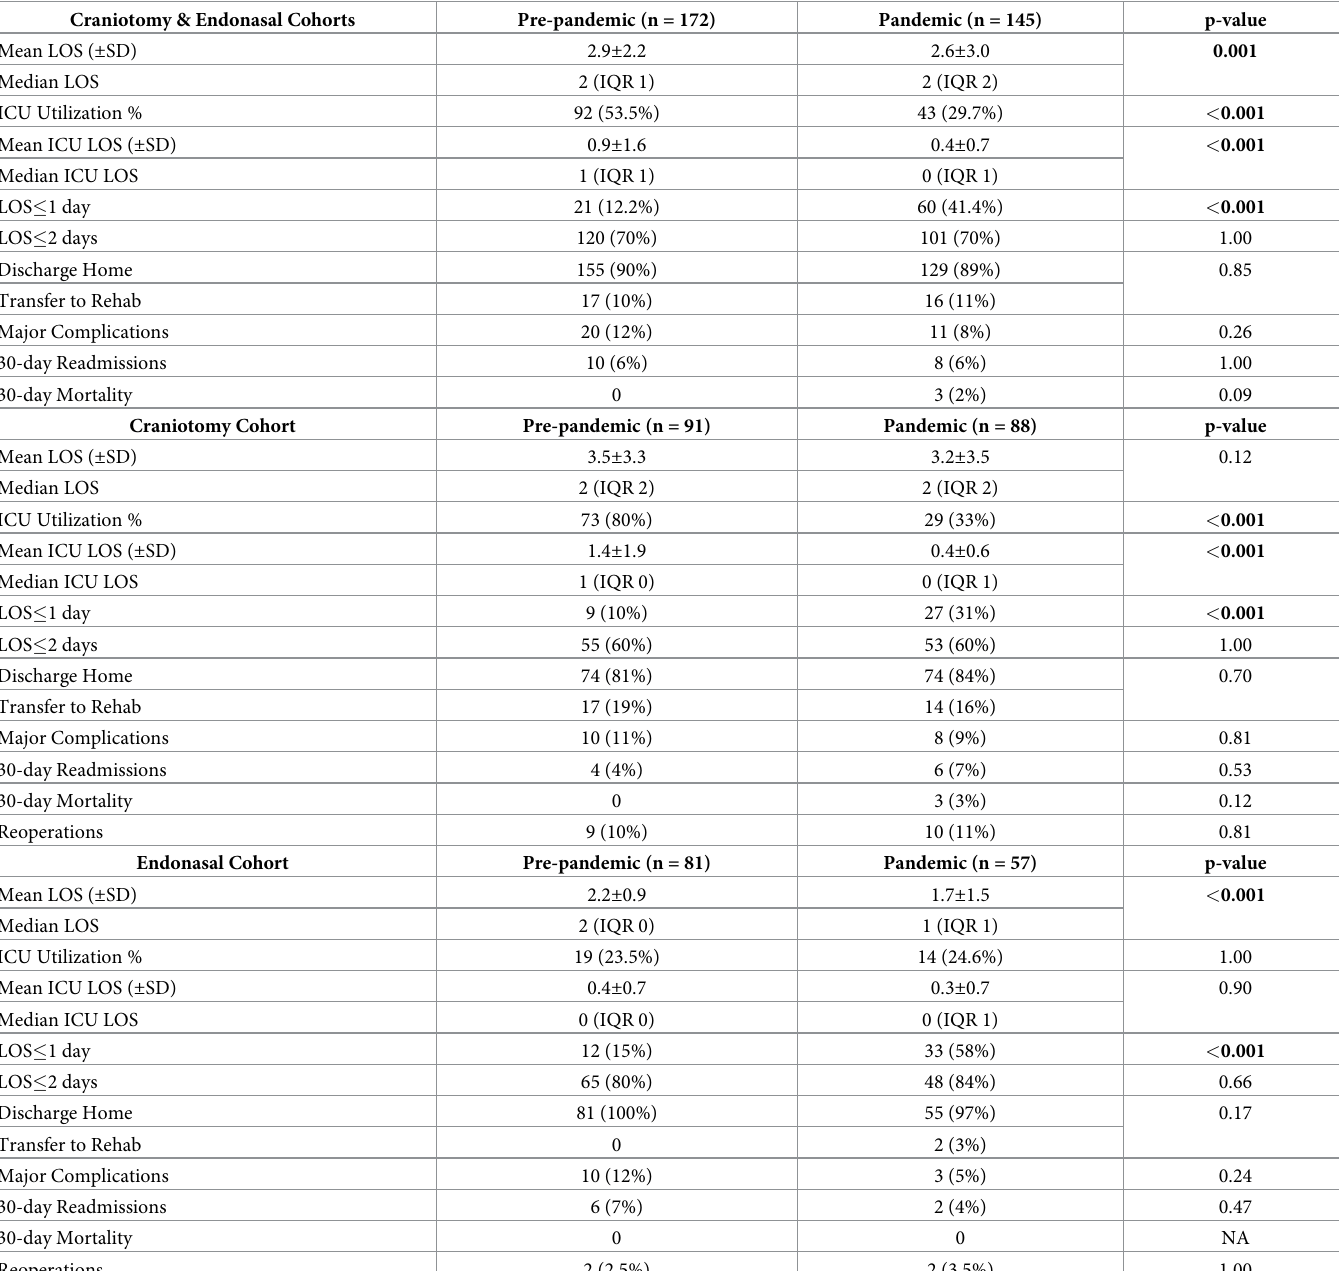
Table 3. Primary and secondary outcomes pre-pandemic versus pandemic epochs. Craniotomy & Endonasal